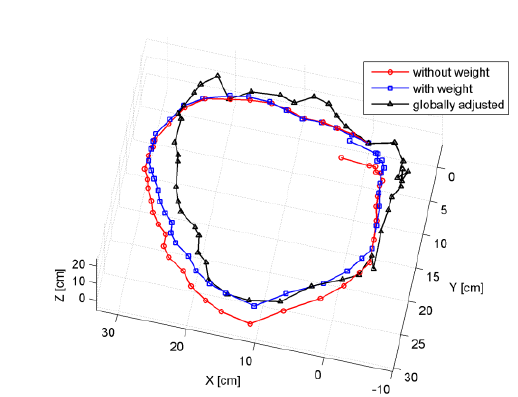
Figure 5. Trajectory obtained by weighted registration of an RGB-D sequence (in blue) compared with the trajectory obtained by registration without weights (in red) and one obtained by global adjustment (in black).